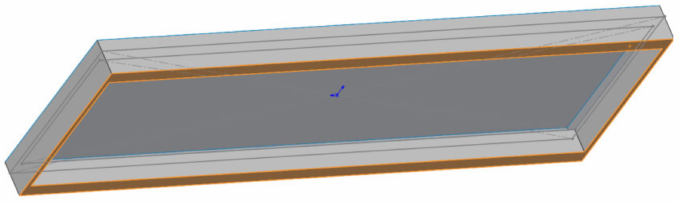
Figure 3. 3D model of the ACAP [23]. 2989 quadrilateral panels are meshed on the boundaries of the ACAP model, as shown in Figure 4. The maximum size of the panels is defined as 0.01 m, and the deformation tolerance is 0.05